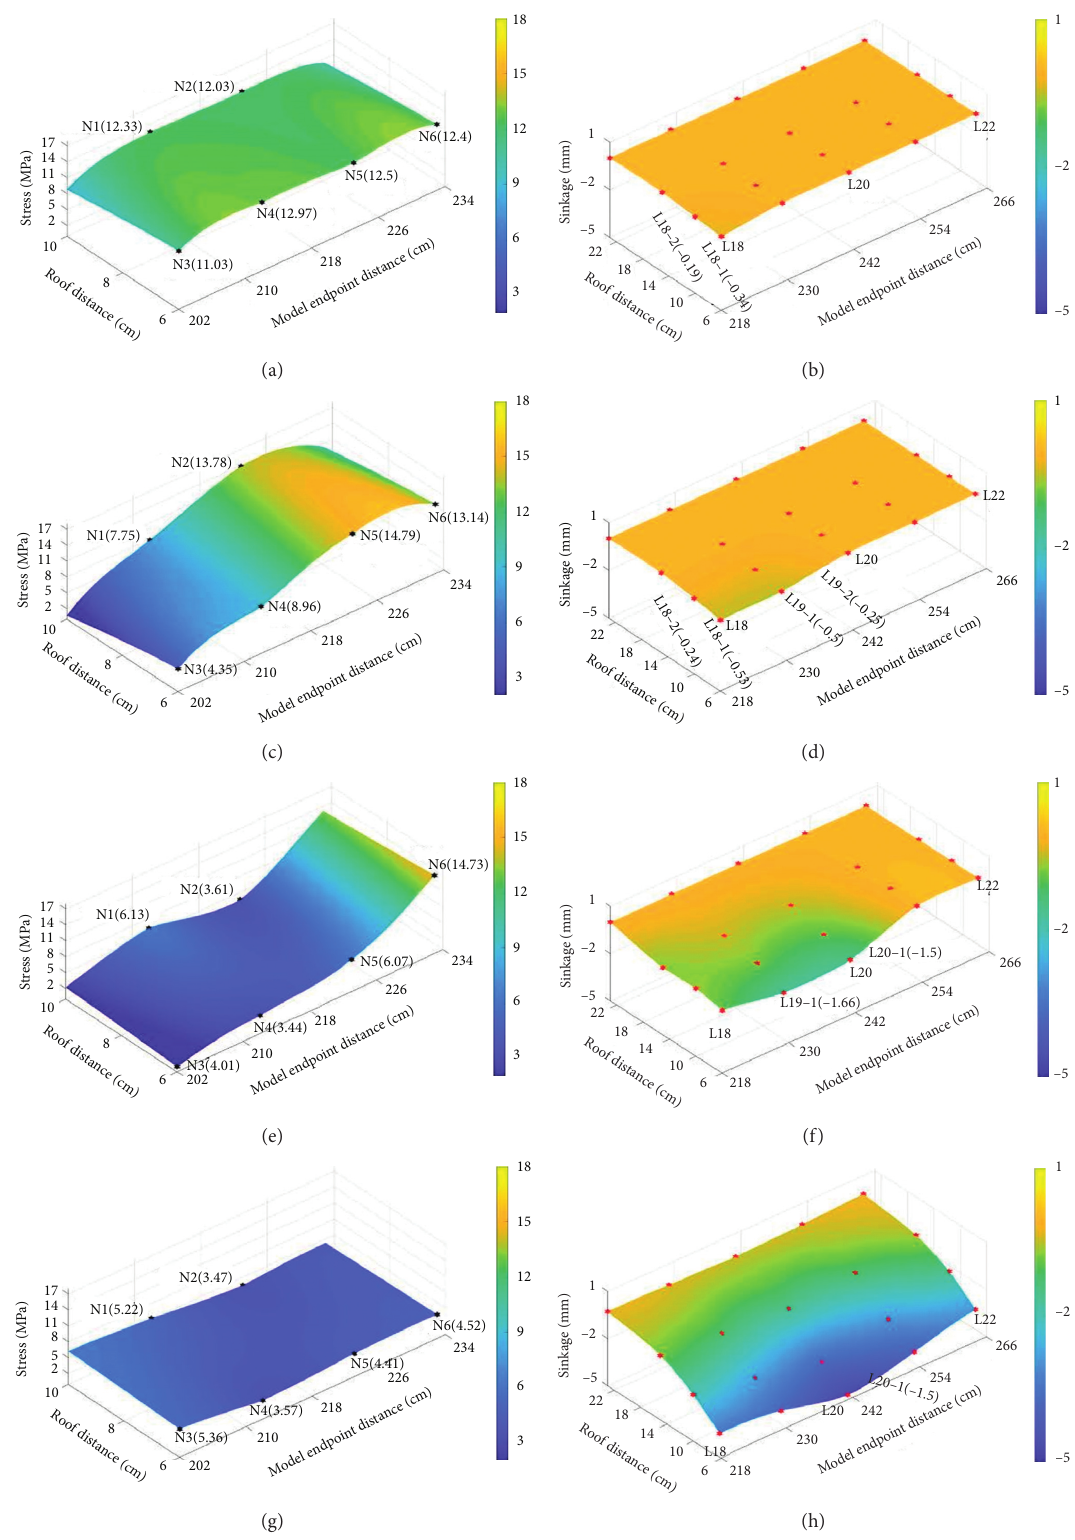
Figure 8: Lower roof stress and overlying rock subsidence in the four-step excavation of the stope structure with 5m ore pillars: (a, b) first step; (c, d) second step; (e, f) third step; and (g, h) fourth